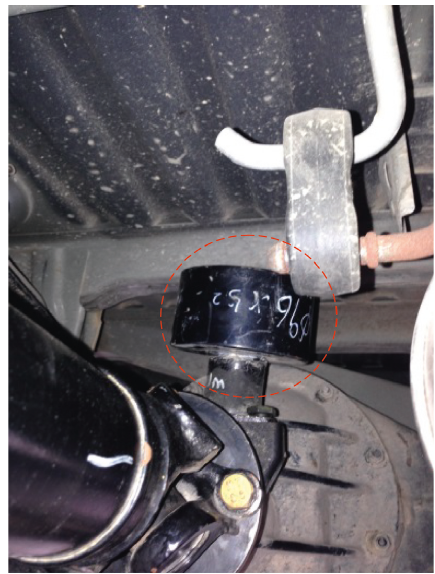
Figure 32: Axle pitching reduction with vertical vibration damper.